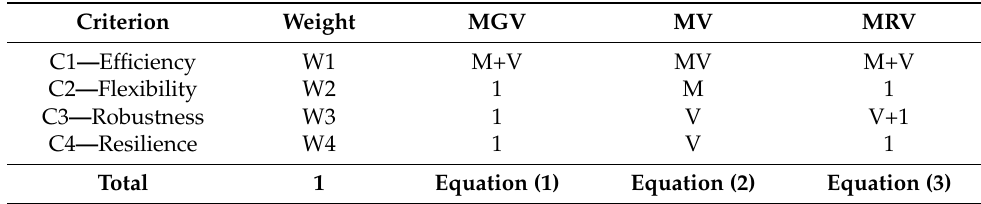
Table 6. Metrics for comparing approaches to generate views from models.